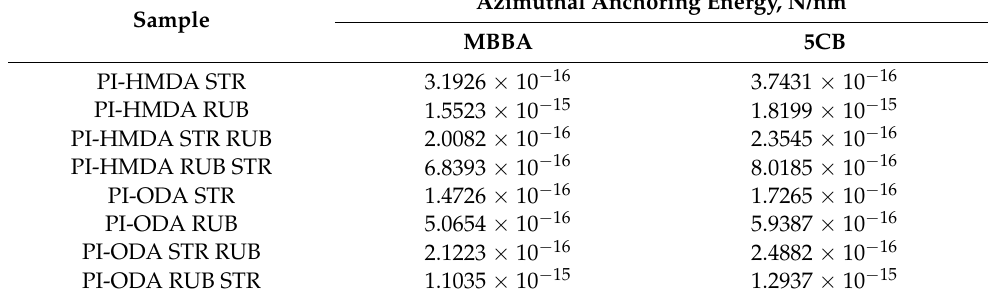
Table 3. The values of the azimuthal anchoring energy of MBBA and 5CB on the polyimides PI- HMDA and PI-ODA after stretching (STR), rubbing (RUB), rubbing after stretching (STR RUB), and stretching after rubbing (RUB